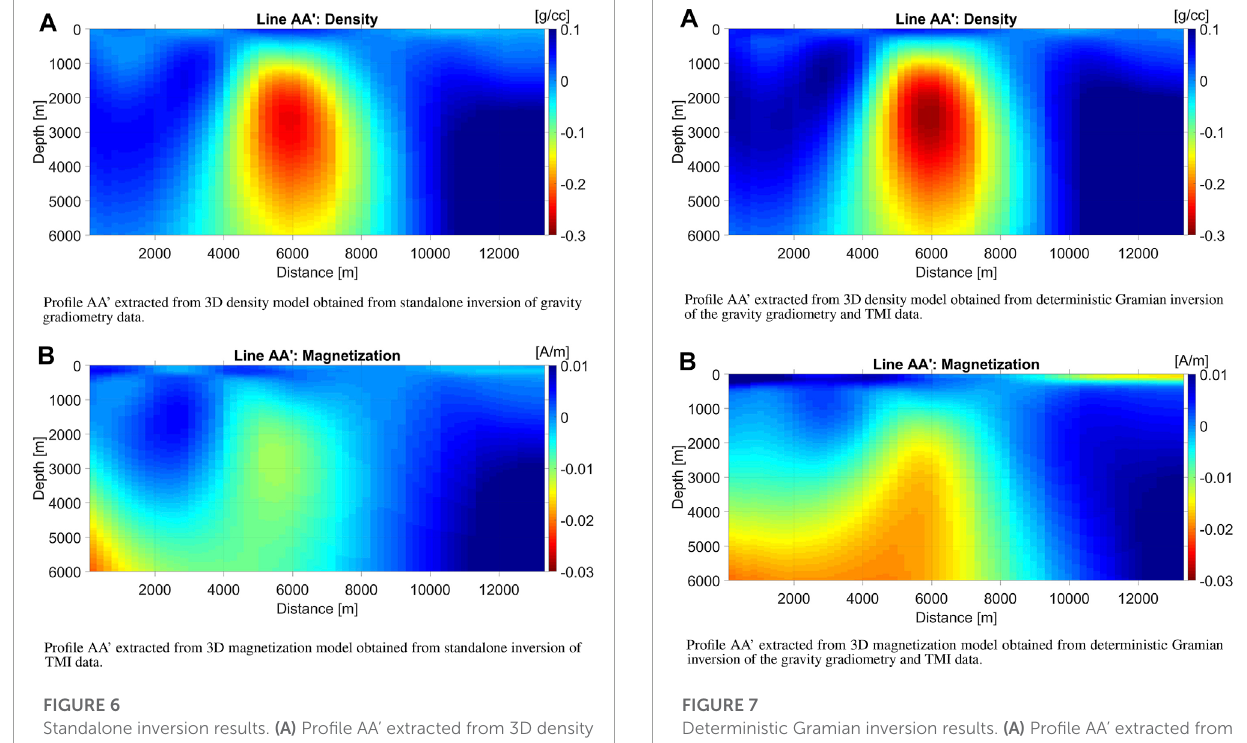
FIGURE 6 Standalone inversion results. (A) Profile AA’ extracted from 3D density model obtained from standalone inversion of gravity gradiometry data. (B) Profile AA’ extracted from 3D magnetization model obtained from standalone inversion of TMI data.